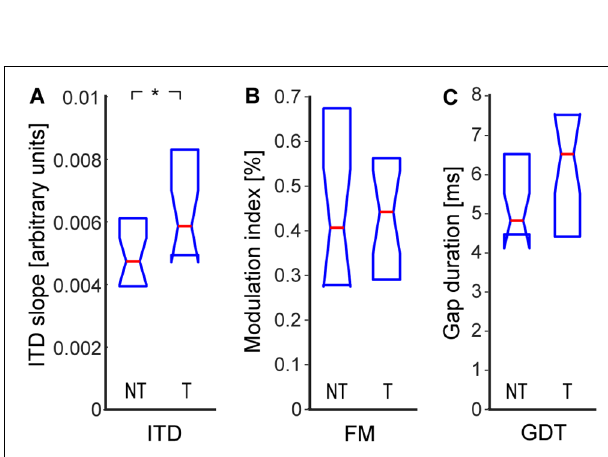
FIGURE 3 | Speech comprehension: speech recognition threshold in quiet (A) , speech in babble noise (B) , gated speech (GS; C ). Medians and IQR. FIGURE 4 | Sensitivity to temporal parameters: interaural time delay (ITD) sensitivity (A) , sensitivity to frequency modulation (FM; B ), gap detection threshold (GDT; C ). Medians and IQR. Statistically significant difference denoted with asterisk (Wilcoxon rank-sum tests; ∗ p < 0.05).